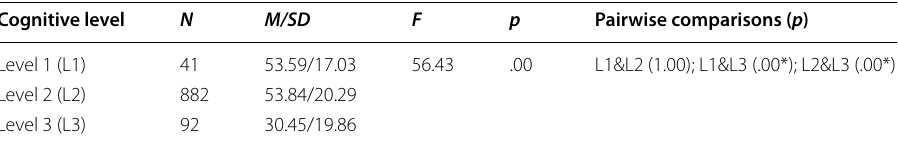
*The Bonferroni-adjusted difference is significant at the level of <0.1%